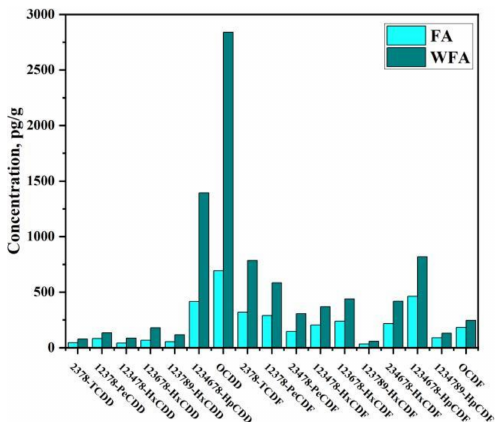
Figure 1. Concentration distribution of 17 toxic PCDD/Fs in FA and WFA.